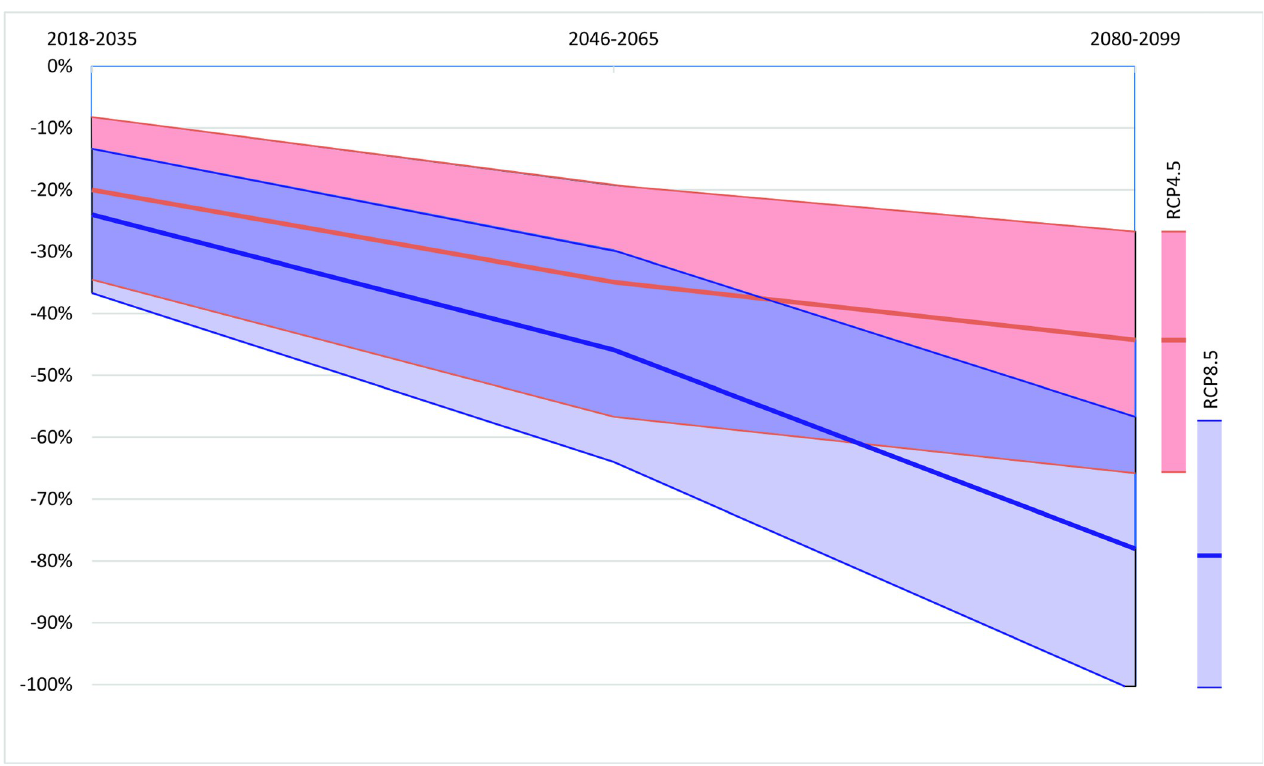
Fig 3. Potential decrease in capture yield due to climate change relative to